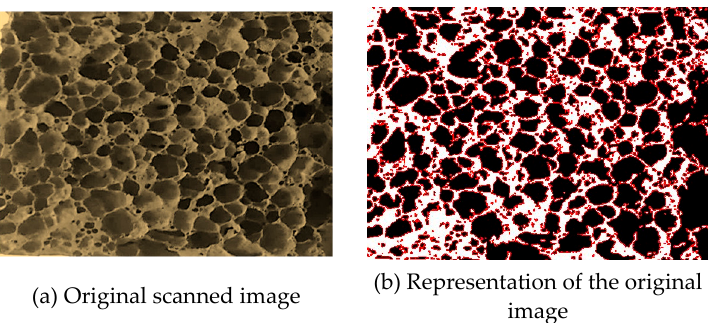
Figure 7. Digital processing of the scanned geopolymer foam plates. ( a ) Original scanned image of the saw-cut flat surface of a sample; ( b ) with black representing the voids, white the flat material matrix and red the extracted void boundaries.